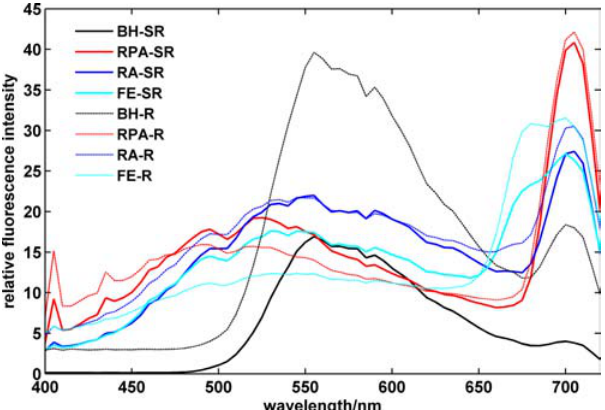
Fig. 3. The relative °uorescence for radix paeoniae alba (RPA-R), radix aucklandiae (RA-R), fructus evodiae (FE-R), BH (BH-R) and their corresponding standard reference mate- rials (RPA-SR, RA-SR, FE-SR and BH-SR).